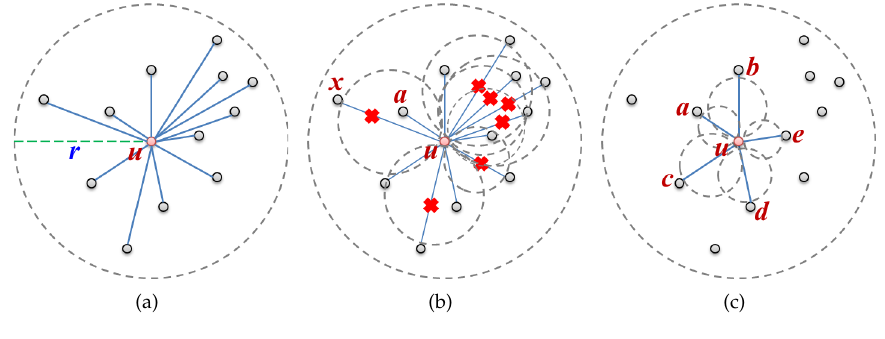
Figure 1. Planarization process: ( a ) local full network graph ( r : radio range); ( b ) planarization; and ( c ) local Gabriel graph